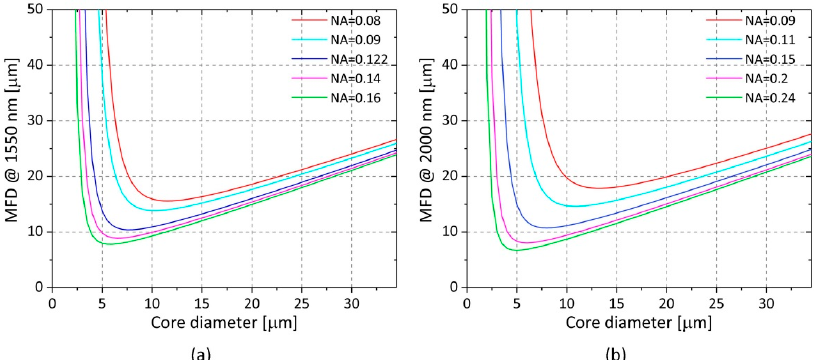
Figure 3. MFD change depending on the core diameter change, calculated for 1550 nm ( a ) and 2000 nm ( b ) wavelength and for different numerical apertures (NAs).